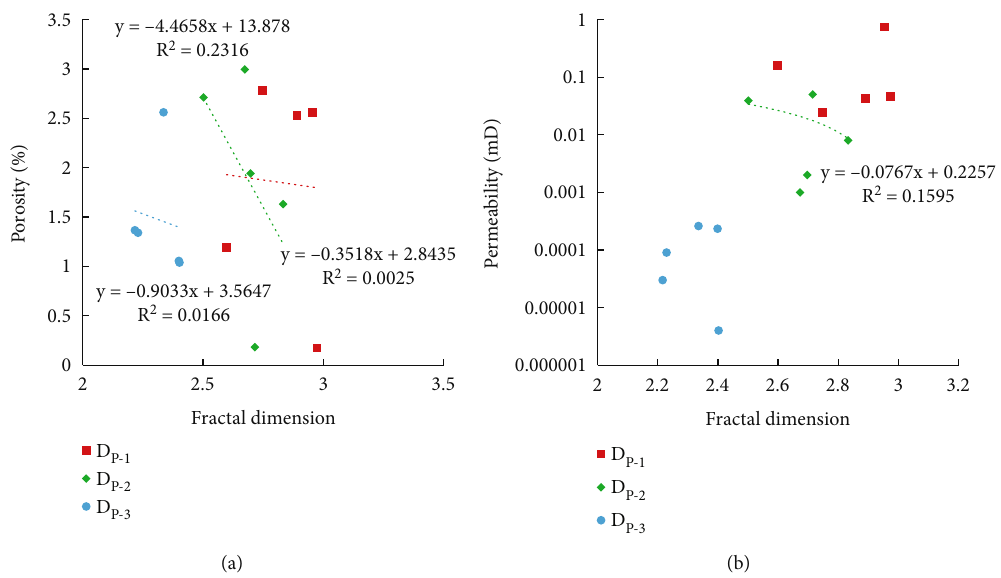
Figure 8: Fractal dimension versus porosity (a), permeability